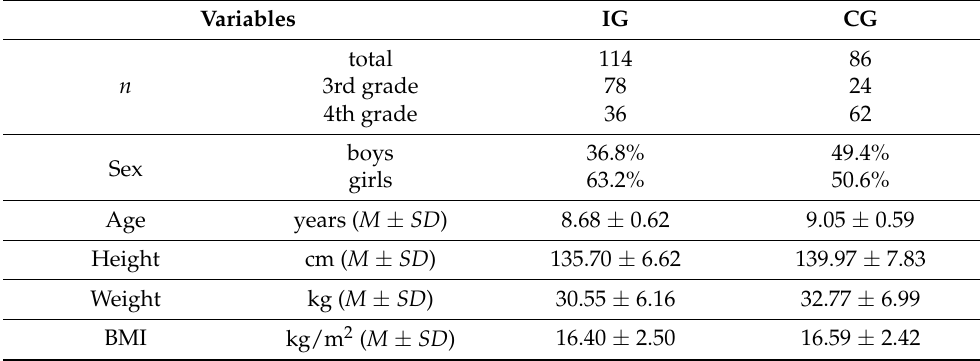
Table 2. Baseline information of intervention (IG) and comparison group